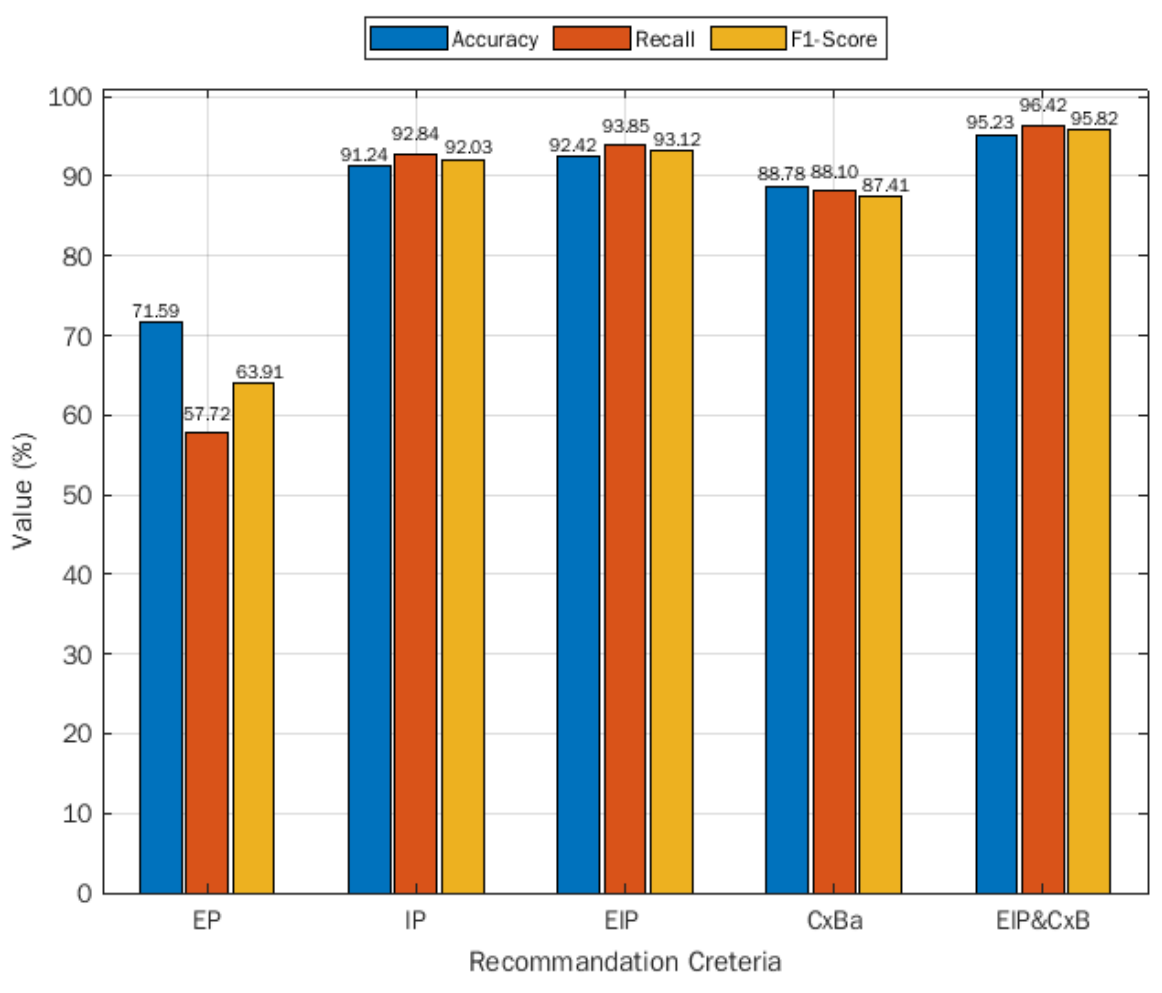
Figure 14. Comparison of accuracy for different criteria by the proposed approach.